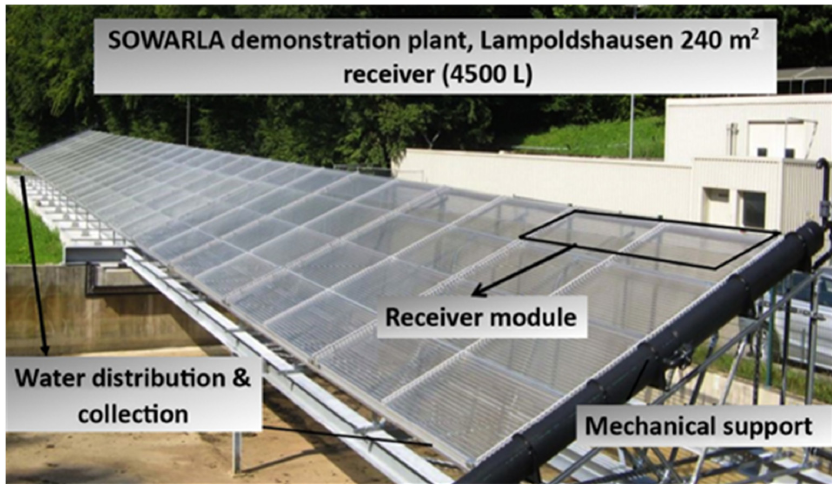
Figure 8. The SOWARLA demonstration plant, (taken with permission from [143]).